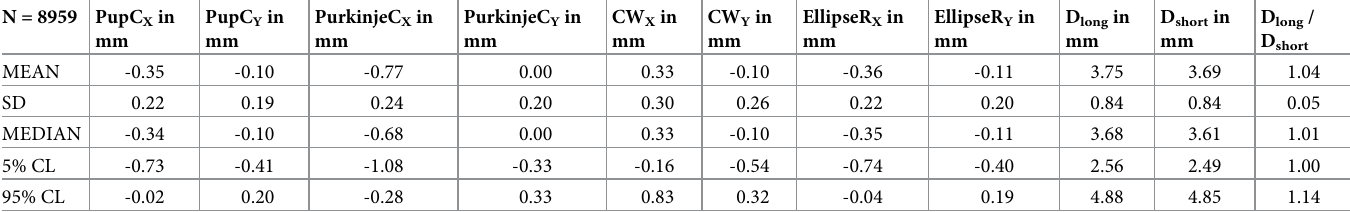
Table 2. Explorative data after raytracing and processing: PupC X , PupC Y , PurkinjeC X , Purkinje C Y , CW X , CW Y refer to the horizontal and vertical coordinates of the pupil centre, Purkinje reflex PI, and Chang-Waring chord as would be noticed by an anterior segment analyser under patient fixation with a far target (pro- jected from Cartesian coordinates X / Y / Z to a plane perpendicular to the incident ray). EllipseR X , EllipseR Y , D long , and D short refer to the horizontal and vertical coor- dinates of the centre and the long and short diameter of the constraint ellipse of the pupil outline derived from raytracing with a bundle of 10,000 rays. Right eyes were flipped in X. MEAN, SD, MEDIAN, 5% CL, and 95% CL refer to mean value, standard deviation, median, and 90% confidence interval, respectively. N = 8959 PupC X in